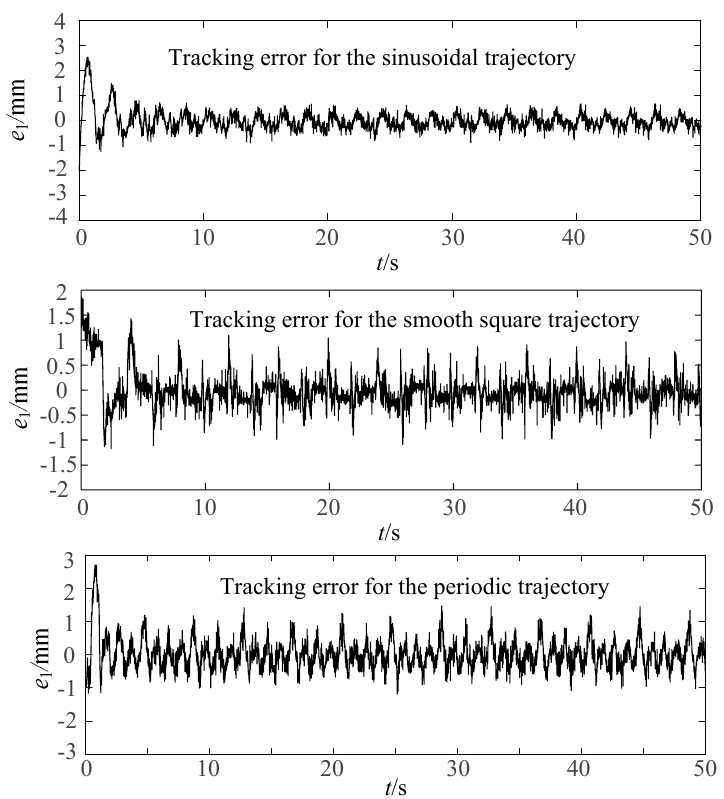
Figure 6. Tracking errors of the proposed controller for three different types of trajectories.